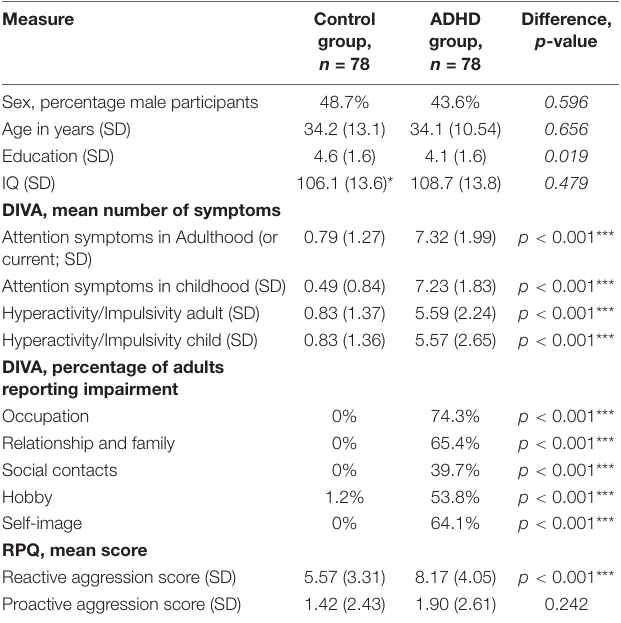
TABLE 1 | Demographic description of the